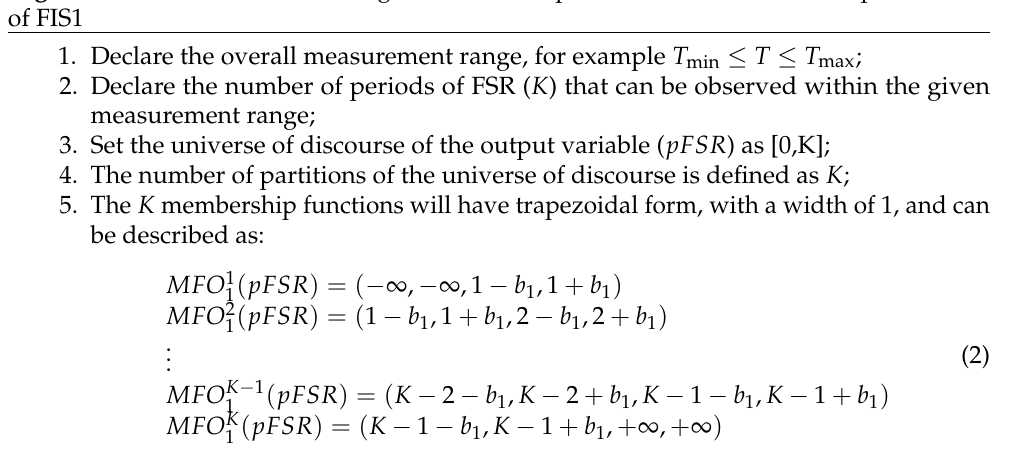
Algorithm 2 Procedure for building the membership functions related to the output variable